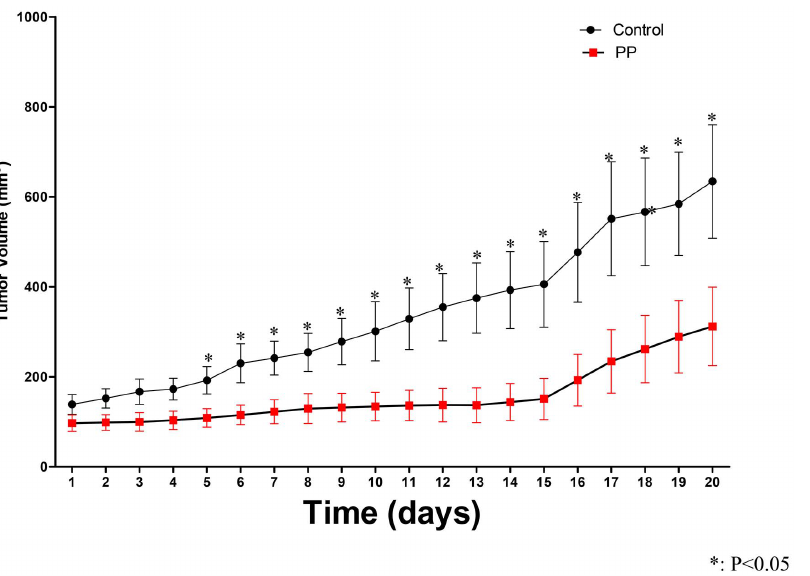
Figure 5. PP inhibited tumor growth invivo when it was administered intraperitoneally. SUM-159 cells were injected into the mammary fat pads of SCID/Beige mice. Once tumors grew to approximately 100 mm 3 , either vehicle (DMSO/saline 50%/50%) or PP was injected IP three times per week. The dose of PP was scaled up according to the following regimen: 1 st dose: 0.1 mg/kg; 2 nd dose: 0.2 mg/kg; 3 rd dose: 0.4 mg/kg; 4 th dose: 0.6 mg/kg; 5 th dose: 0.8 mg/kg; and 6 th dose: 1.0 mg/kg. After the 6 th injection, the dose was kept at 1 mg/kg. PP delayed tumor growth beginning at 4 days of the initial treatment. There were 11 mice in the treatment group and 10 mice in the control group. The Student t -test was used to calculate P value. Error bars indicate standard deviation.